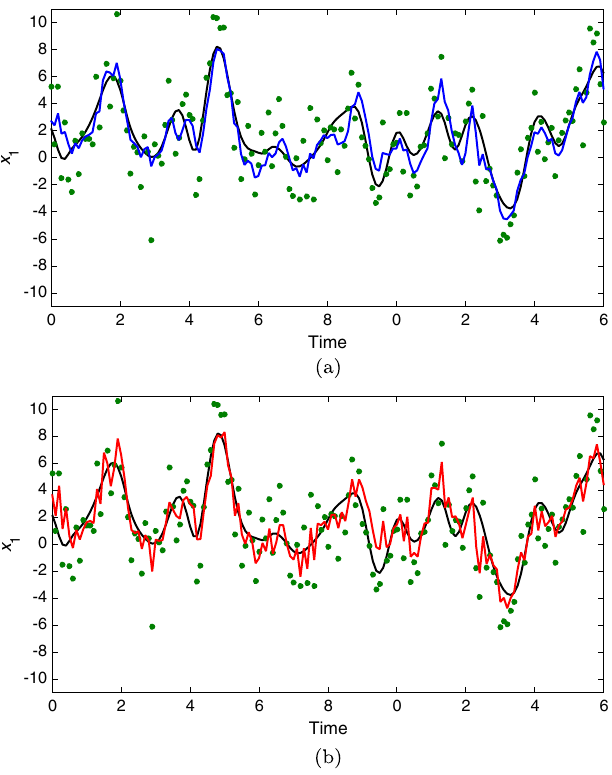
FIG. 5. The filtering problem in a 40-dimensional Lorenz-96 system where noisy observations from 3 of the network nodes are available. Observations are perturbed by 60% noise. The goal is to filter the noisy observations of the x 1 node (black circles) and reduce the signal error (RMSE ¼ 2 . 16 ). Black solid curve denotes true trajectory of variable. (a) The parametric filter (solid blue curve) with full knowledge of the system is able to filter the signal to RMSE ¼ 1 . 17 . This requires full estimation of the 40- dimensional state. (b) The nonparametric Kalman-Takens filter (solid red curve), with no knowledge of the underlying physical system and utilizing only delay coordinates of the observables, is able to filter the signal to RMSE ¼ 1 . 36